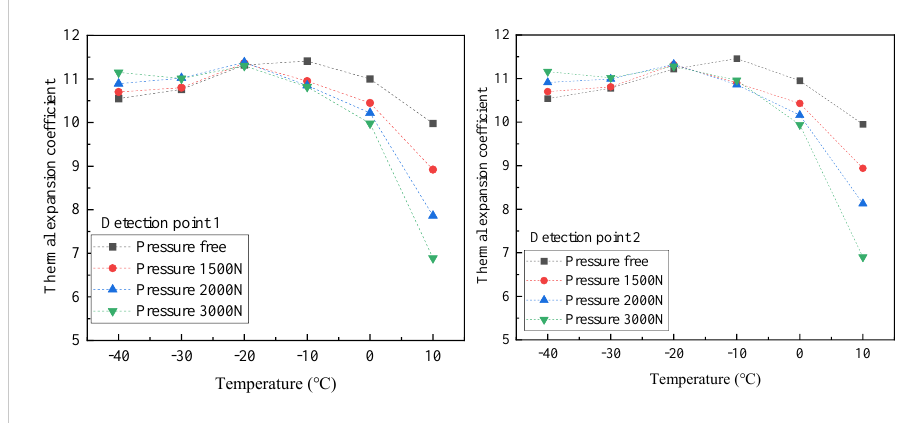
Figure 12. Thermal expansion coefficient of detection point 1 and detection point